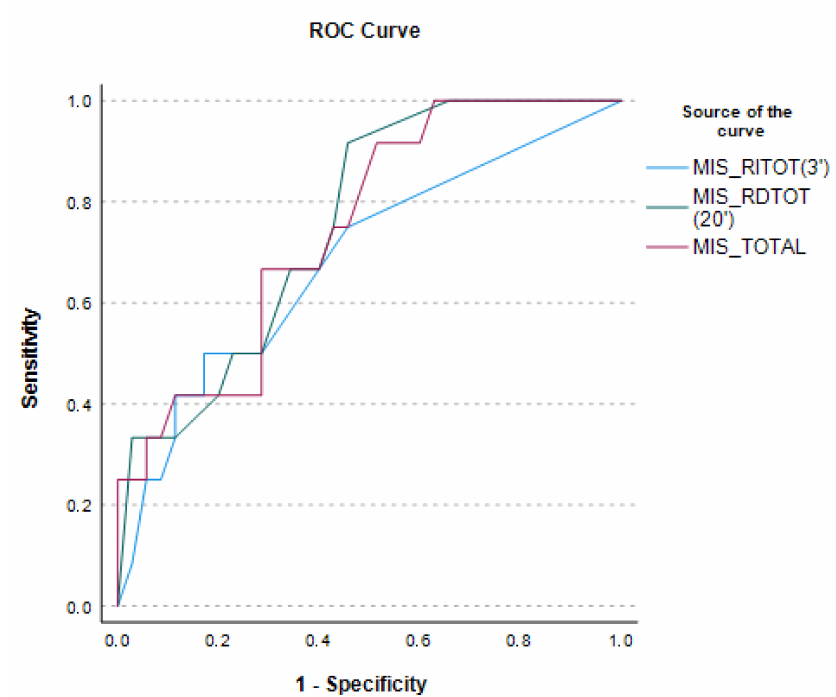
Figure 1. Receiver operating characteristics (ROC) of the PMIS-ID as a screening memory tool for AD in people with a moderate level of